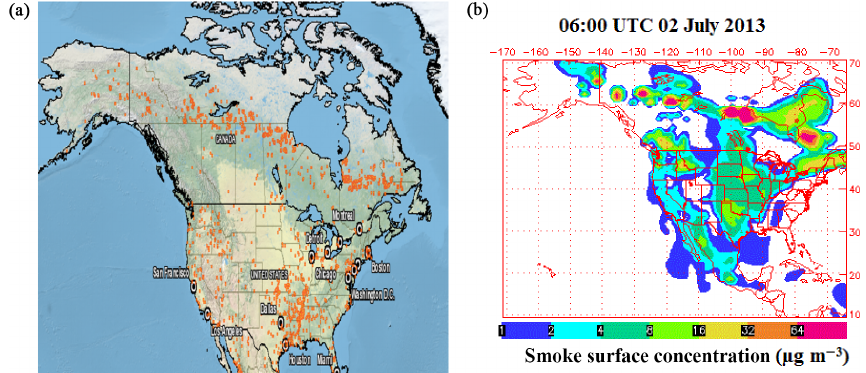
Figure 1. Active fire map for the period from 1 to 15 July 2013 (a) and concentration of smoke particles at the surface according to the NAAPS model, for a specific time (2 July 2016 at 06:00UTC) within the period of intense forest fires in North America (b)